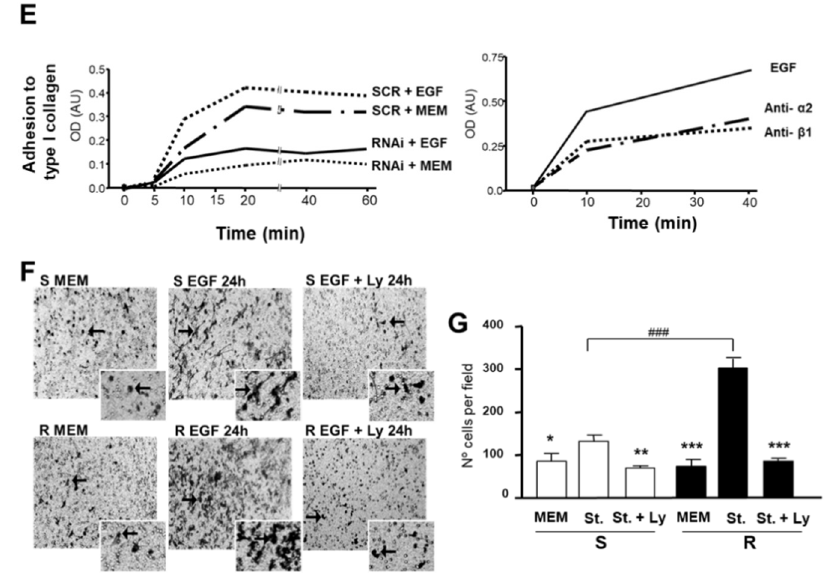
Figure 7. Microscopic and immunoblot analyses of cellular changes in morphology, adhesion, and invasive capacity. ( A ). Western blot assessing the expression and phosphorylation of AKT and ERK 1/2 in control (S) compared with IRS-4 knockdown (R) cells. ( B ). Microscopic images of demonstrating changes in cell morphology in (R) cells compared to (S) cells in basal conditions and after 24 h of EGF incubation. ( C ). Confocal fluorescent microscopic images of (S) and (R) cells stained with Phalloidin-FITC in basal conditions and after 24 h of EGF incubation. ( D ). Confocal fluorescent microscopic images of (S) and (R) cells stained with anti-integrin α 2 (green) in basal conditions and after 1 h of EGF incubation. ( E ) Graphical representation of HepG2 cell adhesion to type 1 collagen. These experiments are representative of three others with similar results. ( F ). Microscopic images of cell migration assessed using a Boyden chamber in basal conditions, 24 h of EGF + type I collagen (St.) incubation, and 24 h St. + Ly294002 incubation. ( G ). Bar graph representation of (F). For comparisons between St. and the other groups, the significance levels using ANOVA test were: * p < 0.05; ** p < 0.01; *** p < 0.001. For comparisons between (R) and (S) cells the significance levels using ANOVA test was: ### p < 0.001. St. = stimulating conditions (EGF + type I